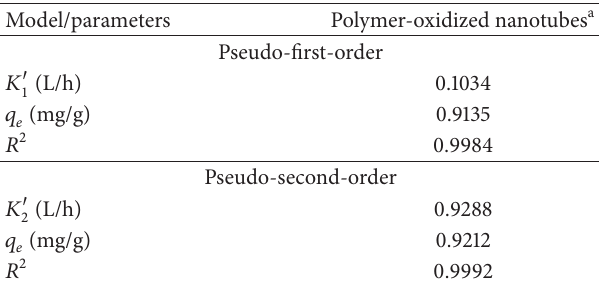
Table 2: Constants for the adsorption kinetics of Cr(VI) from polymer membranes with